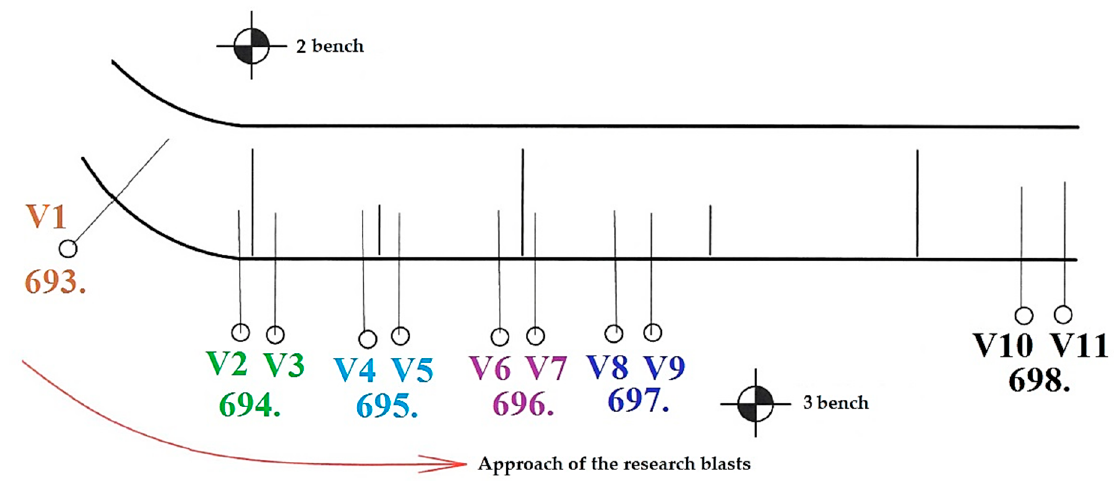
Figure 6. Position of the boreholes on the 3 bench-No. V1—blast 693; V2, V3—blast 694; V4, V5—blast 695; V6, V7—blast 696; V8, V9—blast 697; and V10, V11—blast 698 in Trebejov Quarry [48].